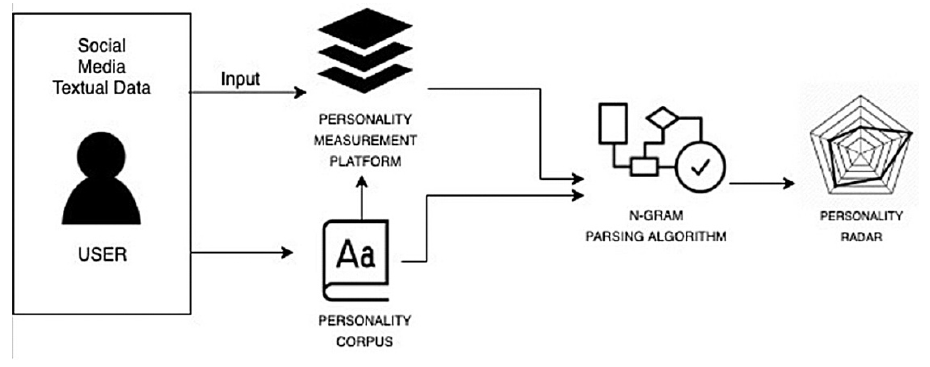
Figure 5. Platform architectural diagram.